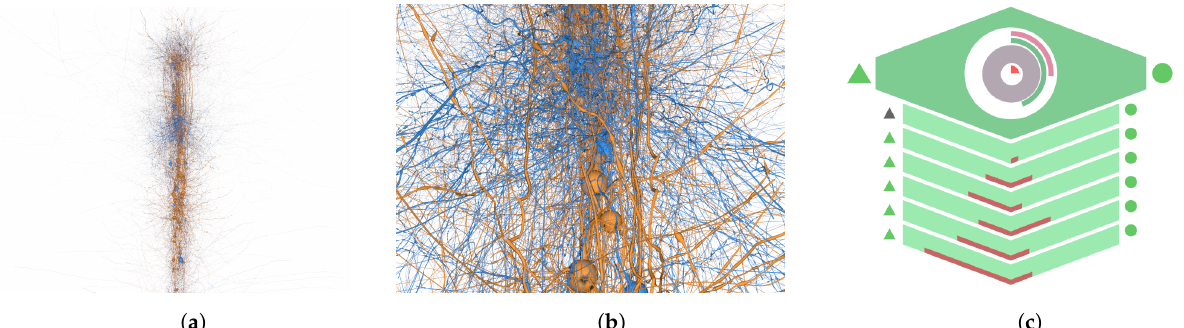
Figure 4. Geometric and abstract windows for exploring a microcolumn. ( a ) Realistic representation: far view; ( b ) realistic representation: closeup view; ( c ) abstract